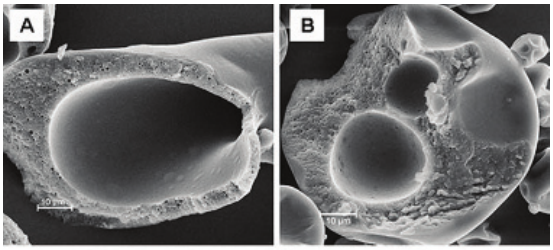
Fig. 4 Scanning electron micrographs of spray-dried fish oil microcapsules. A higher inlet/outlet temperature results in lower-density powders as the particles are elongated with large volumes of included air (a: 210/90 ℃ ; b: 160/60 ℃ ) 78)